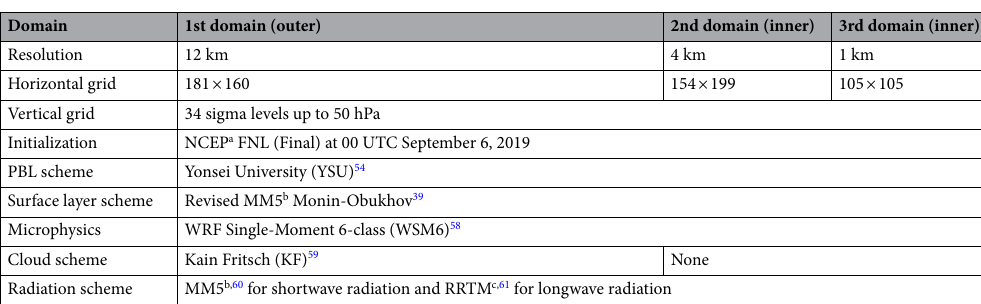
Table 1. WRF configurations used in this study. a National Centers for Environmental Prediction. b